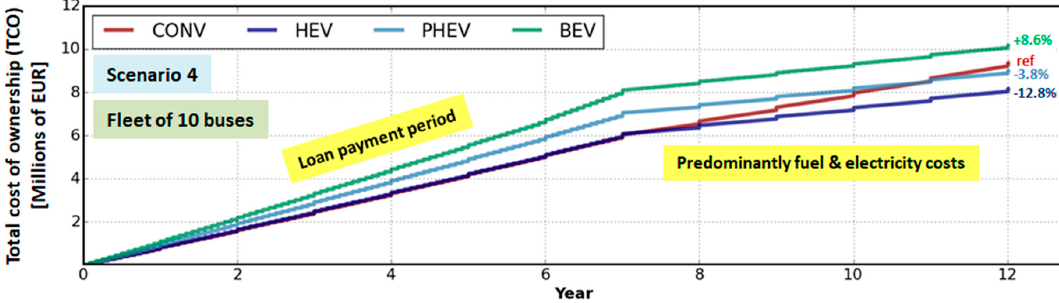
Figure 19. Cost shares for different type of bus fleets and Scenario 4 from Figure 18.